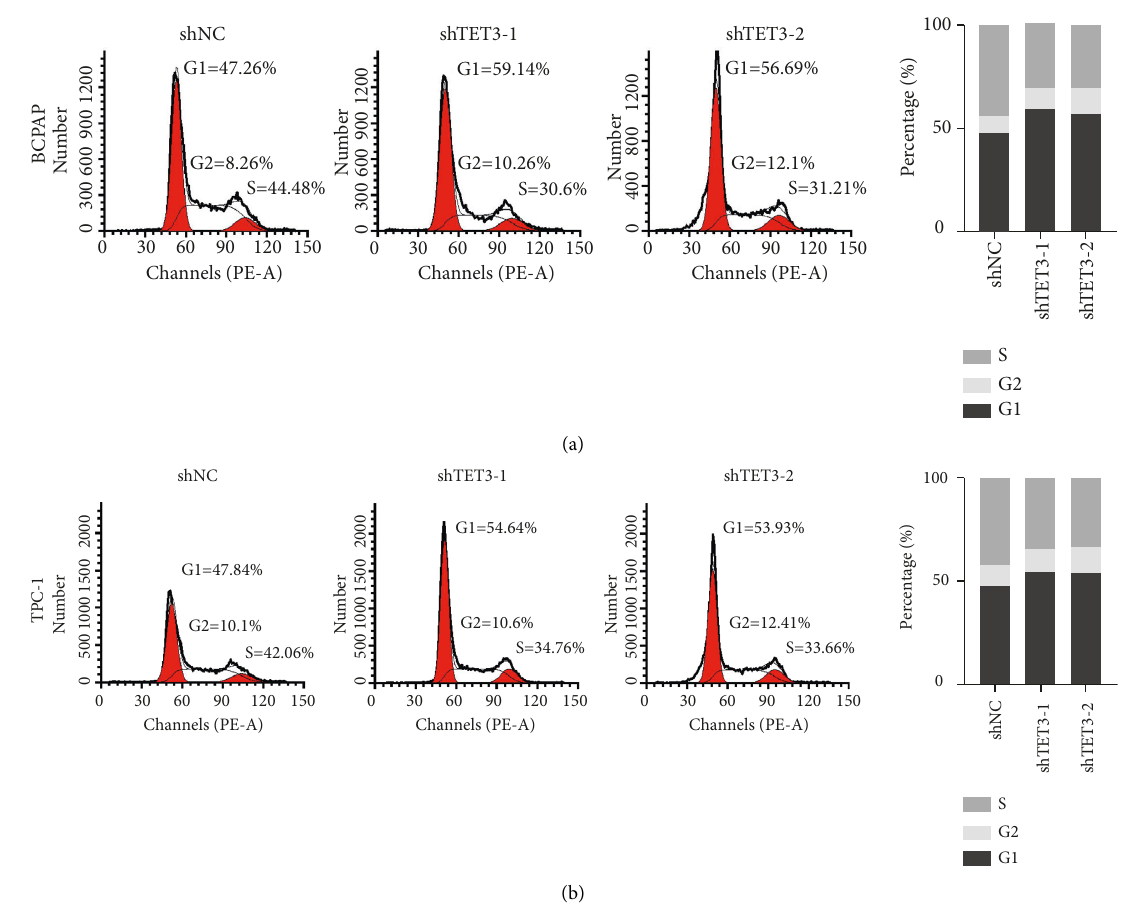
Figure 3: Knockdown of TET3 significantly induced cell-cycle G1/S arrest and summarized data regarding the cell numbers at each cell- cycle phase after TET3 knockdown in BCPAP (a) and TPC-1 (b)